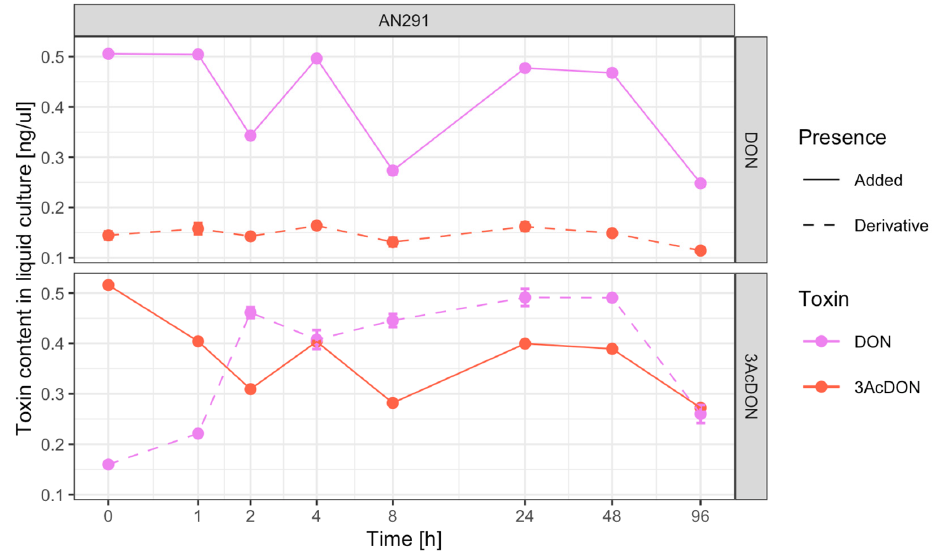
Figure 7. Changes in the content of DON and 3 ‐ AcDON mycotoxins in parallel during 96 h of culturing the C. rosea AN291 strain in a liquid medium with the addition of 3AcDON or DON.